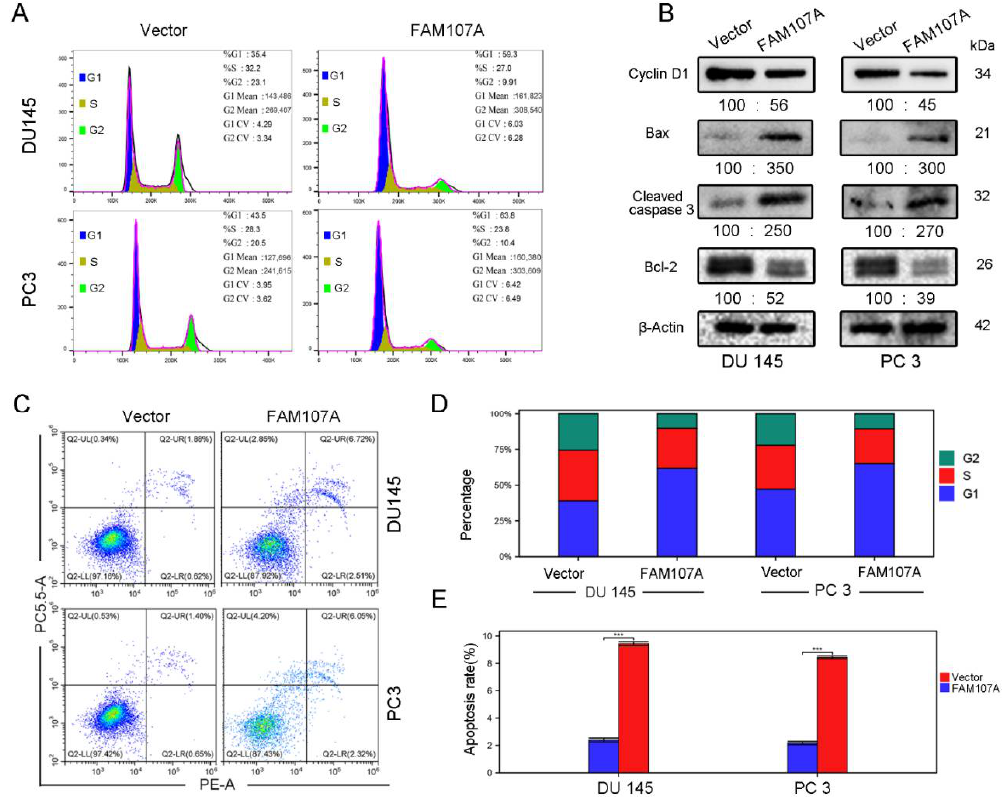
Figure 6. Overexpression of FAM107A promotes prostate cancer cell cycle arrest and induces apopto- sis in prostate cancer cells. ( A ) Detection of the effect of FAM107A on the cycle of DU 145 and PC 3 cells using flow cytometry. ( B ) Western blotting to verify changes in cyclin D1 and apoptosis markers Bax, Cleaved caspase-3, and Bcl-2. ( C ) Detection of apoptosis rate of both groups of cells using flow cytometry. ( D , E ) Quantitative analysis of cell cycle changes and changes in apoptosis rates. Data are expressed as the mean ± standard deviation of at least three experiments. *** for p < 0.001.